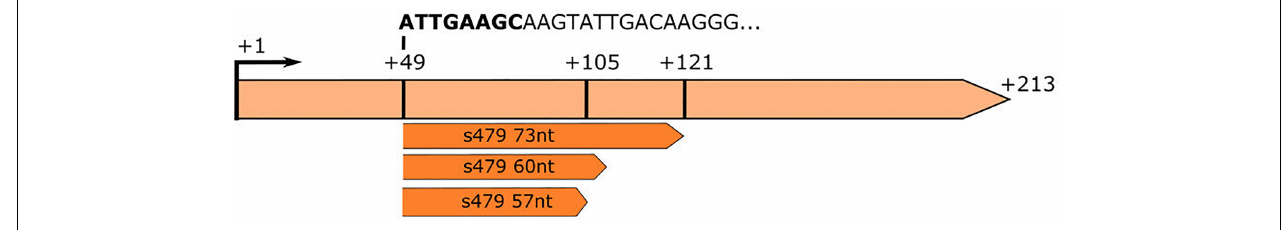
FIGURE 3 | RNA-seq analysis of small RNAs reveals sequences matching the s479 locus. The s479 precursor RNA is 213 nucleotides long, shown in light orange. RNomics analysis of size-selected RNA samples (Maier et al., 2013) reveals shorter versions of s479: 57, 60, and 73 nt in length, shown below in dark orange. These data confirm the results of the northern blot ( Figure 2 ). The sequence of the shorter sRNAs starts at nucleotide 49 of the precursor. The first 8 nucleotides are identical to crRNA 5 (cid:48) handle sequence (shown in bold: ATTGAAGC) ( Supplementary Figure 2 ).